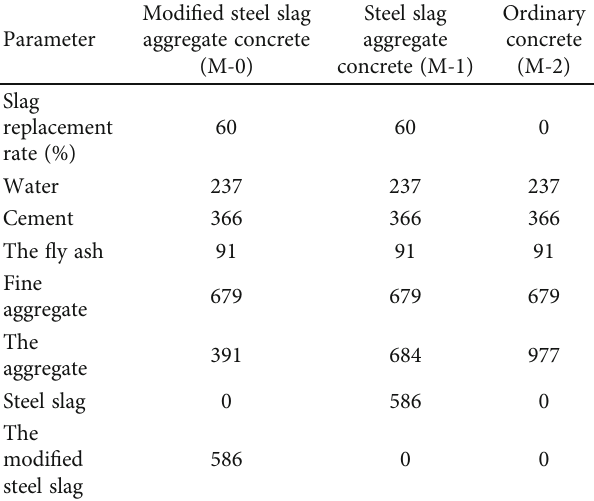
Figure 2: Variation curve of mass loss rate of steel slag concrete with erosion